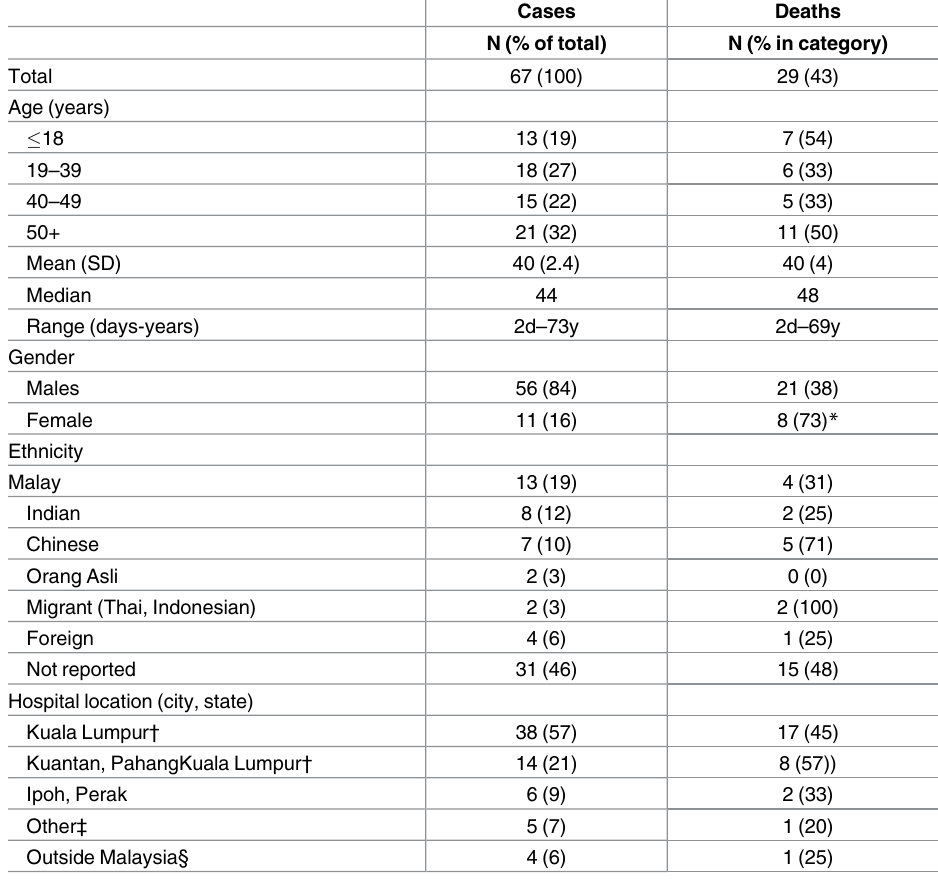
Table 1. Distribution of cases by selected characteristics and associated deaths.